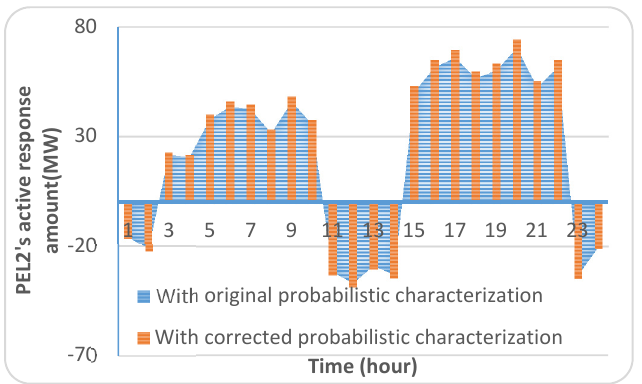
Figure 11. Demand response Amount of PEL2 with Changing